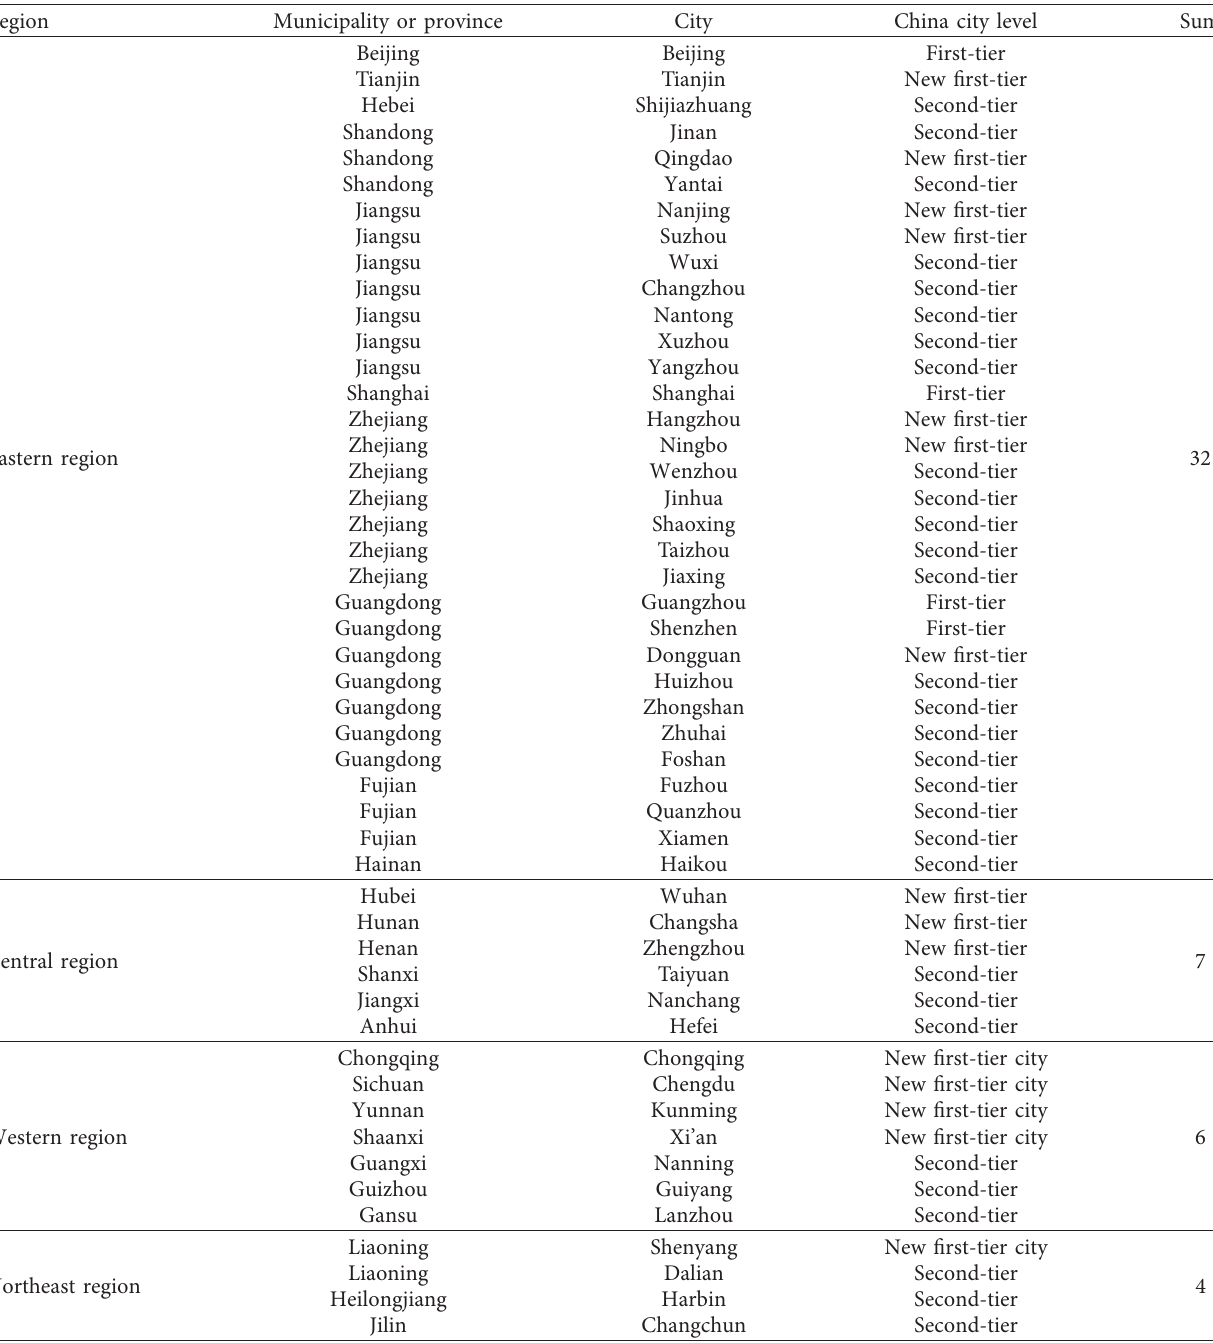
Table 1: Description of specific research